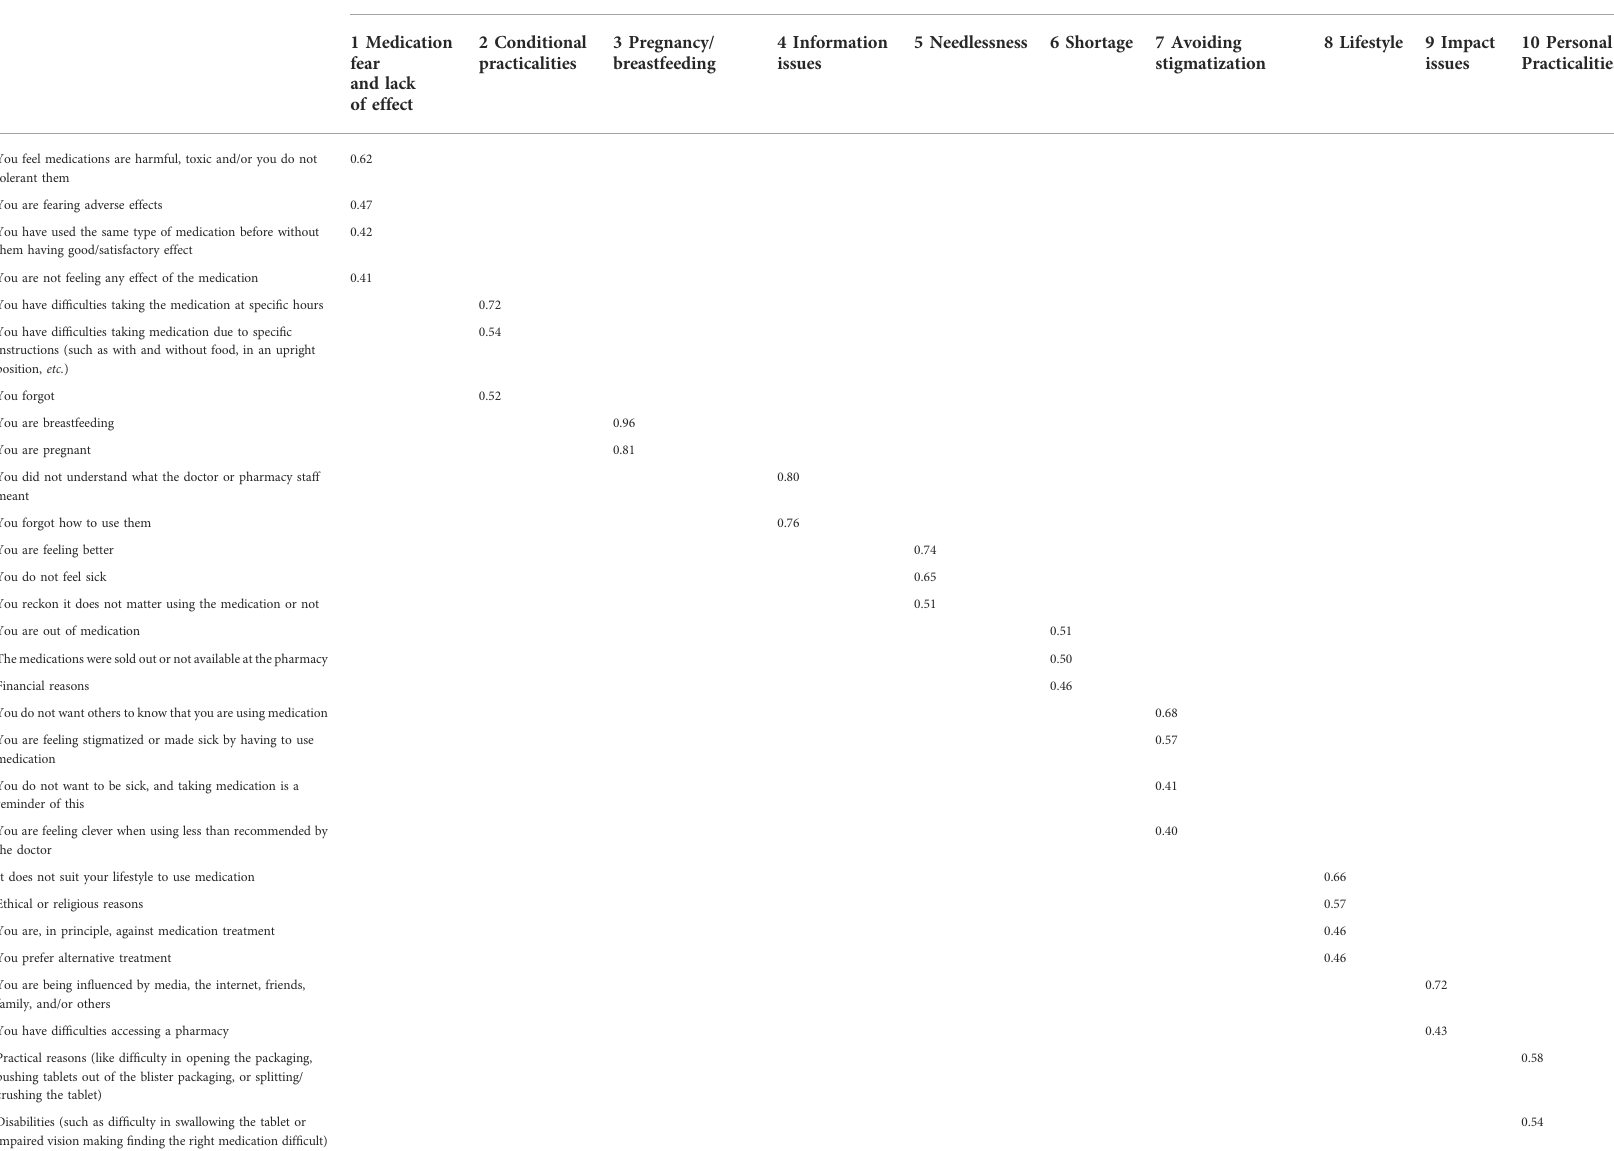
TABLE 5 Pattern matrix for PAF extraction, oblimin with Kaiser normalization rotation and loading > +/ −